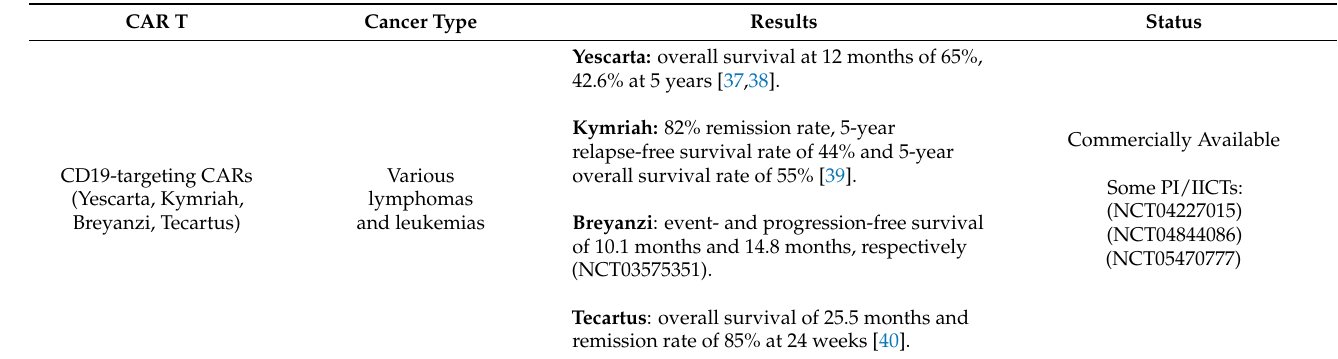
Table 2. Overview of the clinical results of currently available CAR T cell products and some concepts undergoing clinical